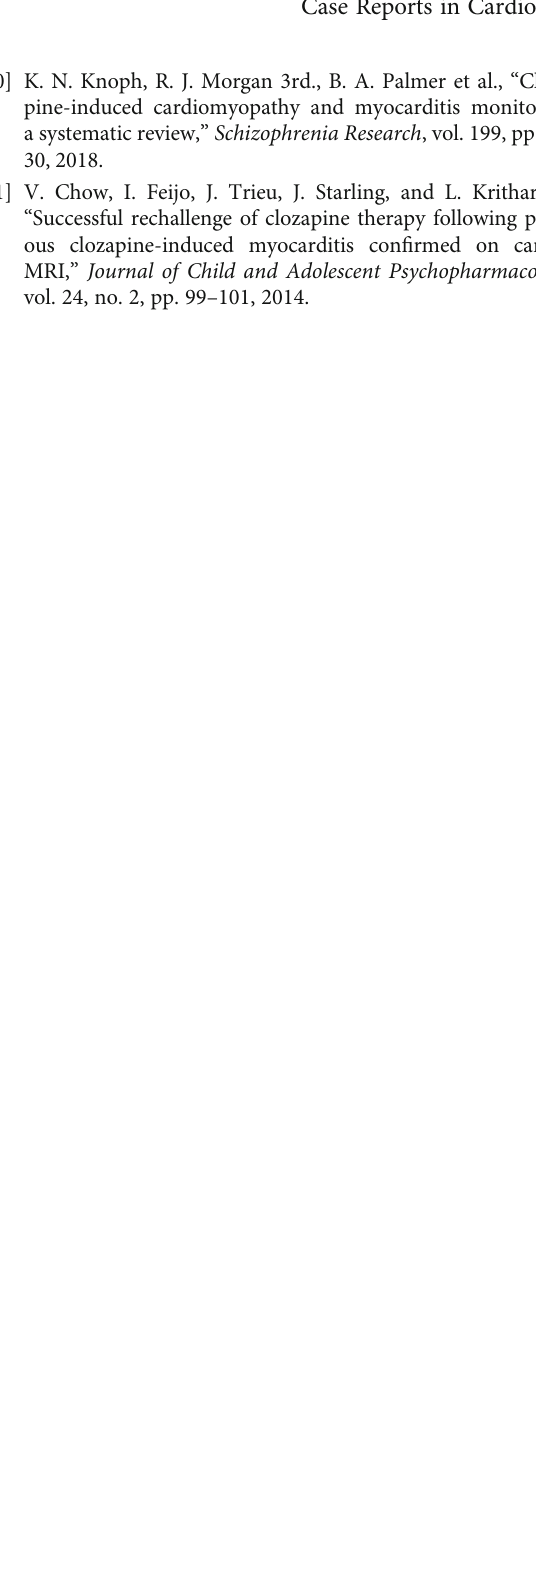
Figure S1: Left ventricular function on presenting cardiac MRI. Four chamber (a) and axial cine stacks (b) obtained at presentation showed left ventricular ejection fraction of 45% by volumetric assessment with mild inferolateral hypo- kinesis and a trivial pericardial e ff usion. Figure S2: Follow- up transthoracic echocardiogram. One week after clozapine cessation and initiation of heart failure therapies, follow-up echocardiogram showed normalization of left ventricular function with no wall motion abnormalities on apical 4 chamber (a) and short axis (b) cines. (Supplementary